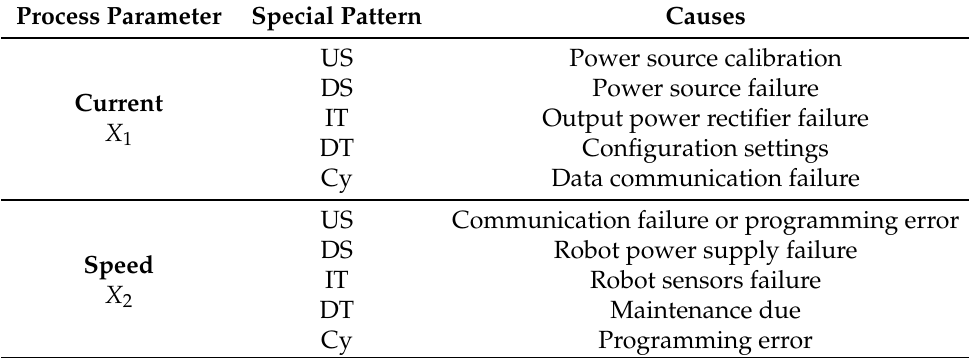
Table 6. Summary of special patterns and possible